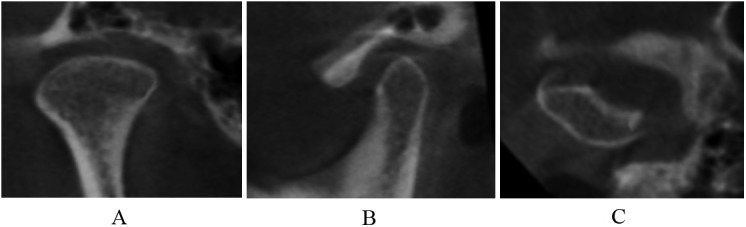
Articular surface flattening in coronal (A), sagittal (B), and axial (C) images.